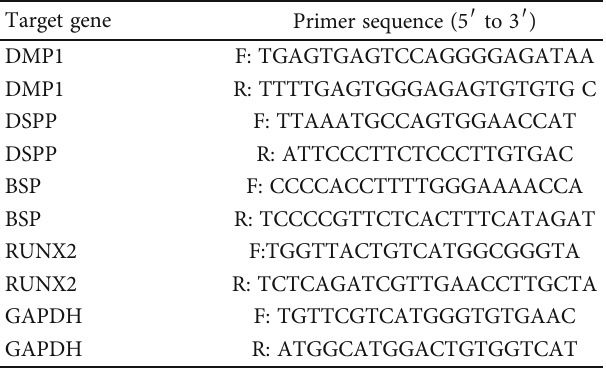
Table 1: RT-PCR primers for the target genes. Target